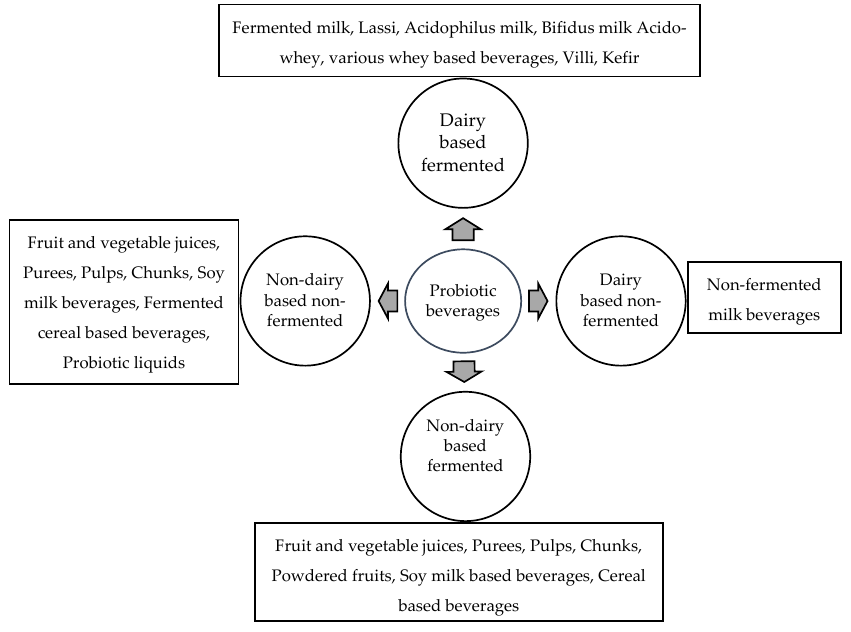
Figure 1. Classification and types of probiotic beverages. Adapted and modified from [115,120].